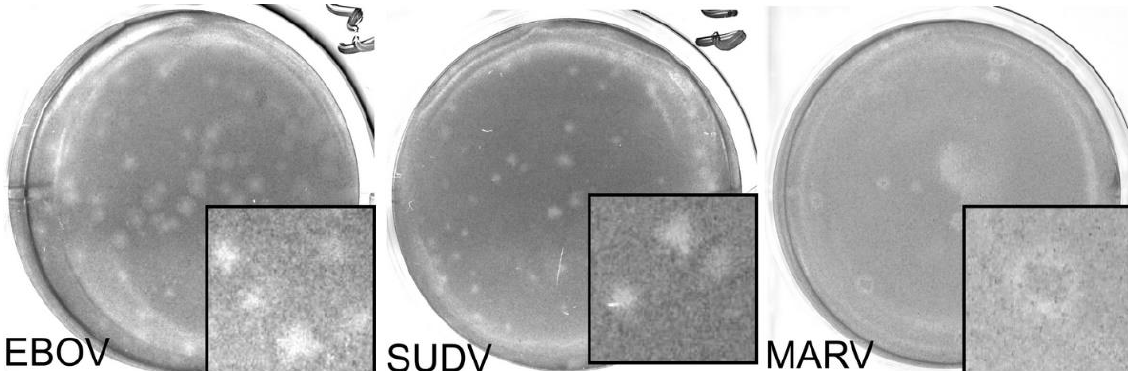
Figure 3. Representative images for Neutral Red plaque assays in EBOV, MARV, and SUDV. Here, a single well from a 6 well plate is used as a representative image for EBOV (left), SUDV (middle), and MARV (right) with insets (3.5 mm width) showing a magnified area. A zone of clearing can be seen in each of the representative wells pictured, although plaque size may vary. This may lead to discrepancy between counters, especially at higher titers. Dilutions pictured here: EBOV 10 −3 , SUDV 10 −3 , MARV 10 −4.